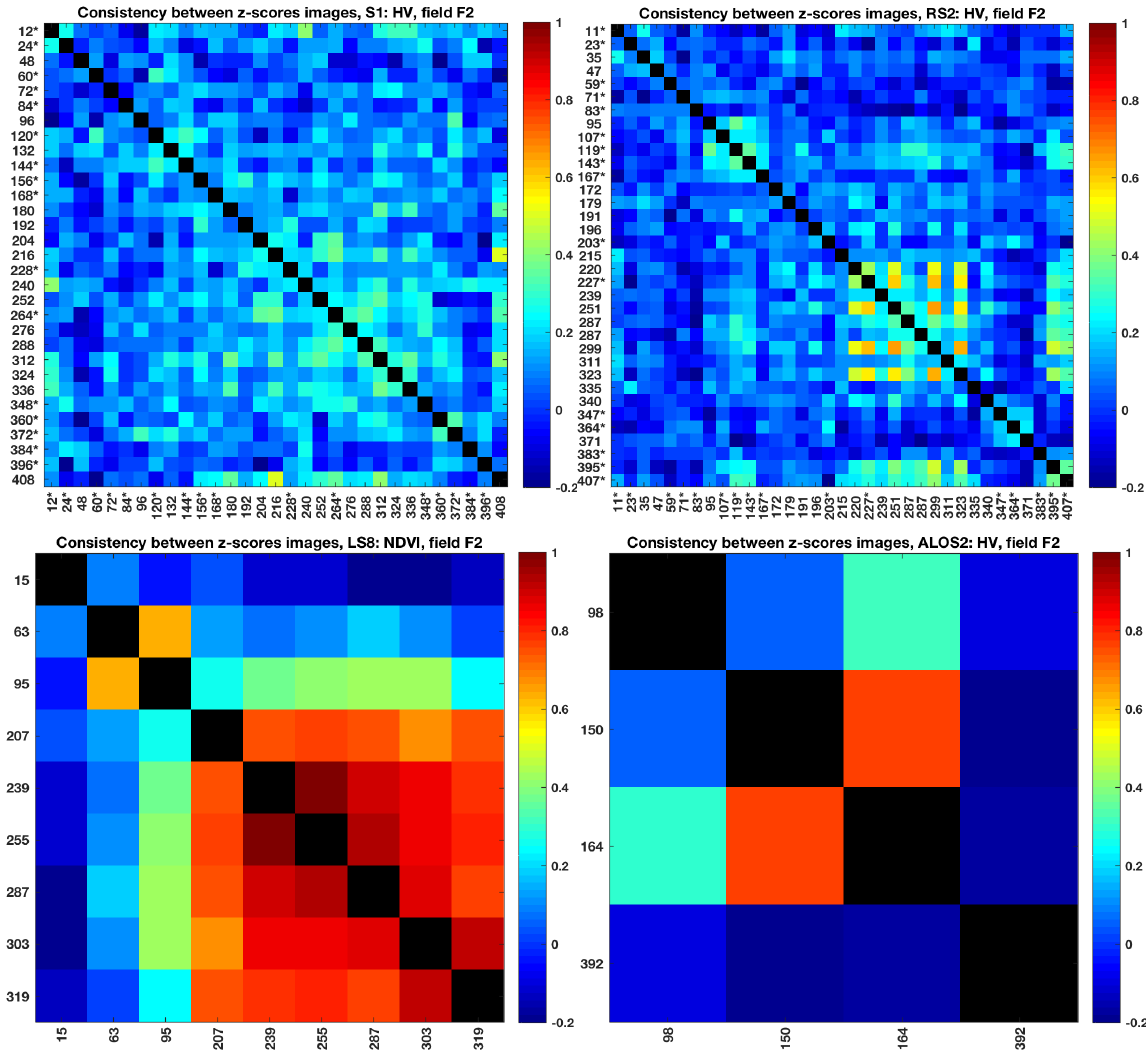
Figure 13. Consistencies of all image combinations for different sensors. Both axes show days from start of growth and asterisks indicate which acquisitions were rain-affected. Diagonal values were omitted and colored black. The harvest of this field was 419 days after start of